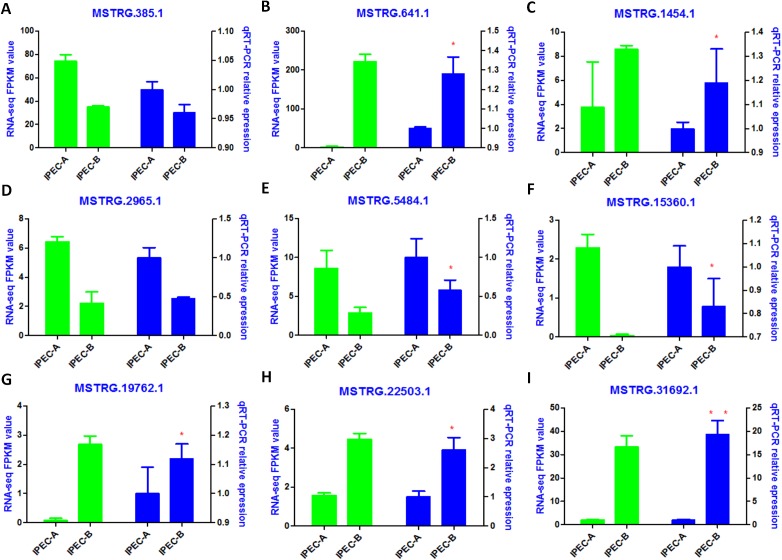
Validation of RNA-Seq data by qRT-PCR.Left Y-axis shows the FPKM values of the selected lncRNAs (A–I) using RNA-seq, whereas the right Y-axis shows the relative expression levels of selected lncRNAs (A–I) using qPCR. * indicates P < 0.05.